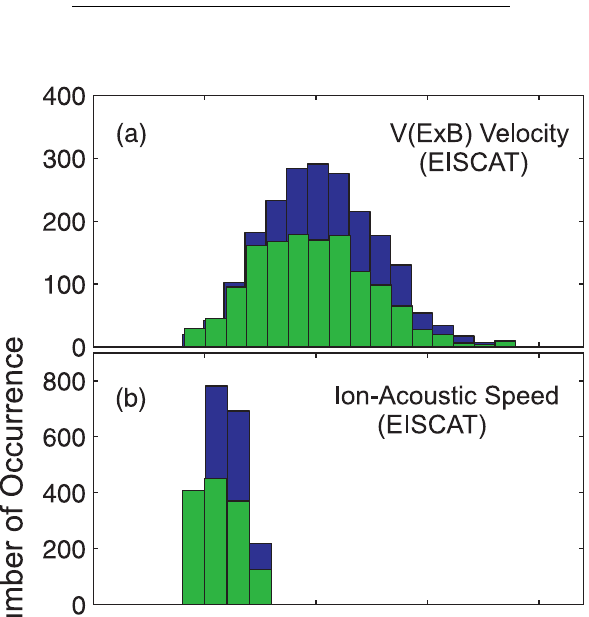
Fig. 2. A comparison of the predicted and measured velocity for the Norway radar according to the model of Bahcivan et al. (2005). Three possible heights of backscatter are considered: (a) 111km, (b) 105km and (c) 99km.